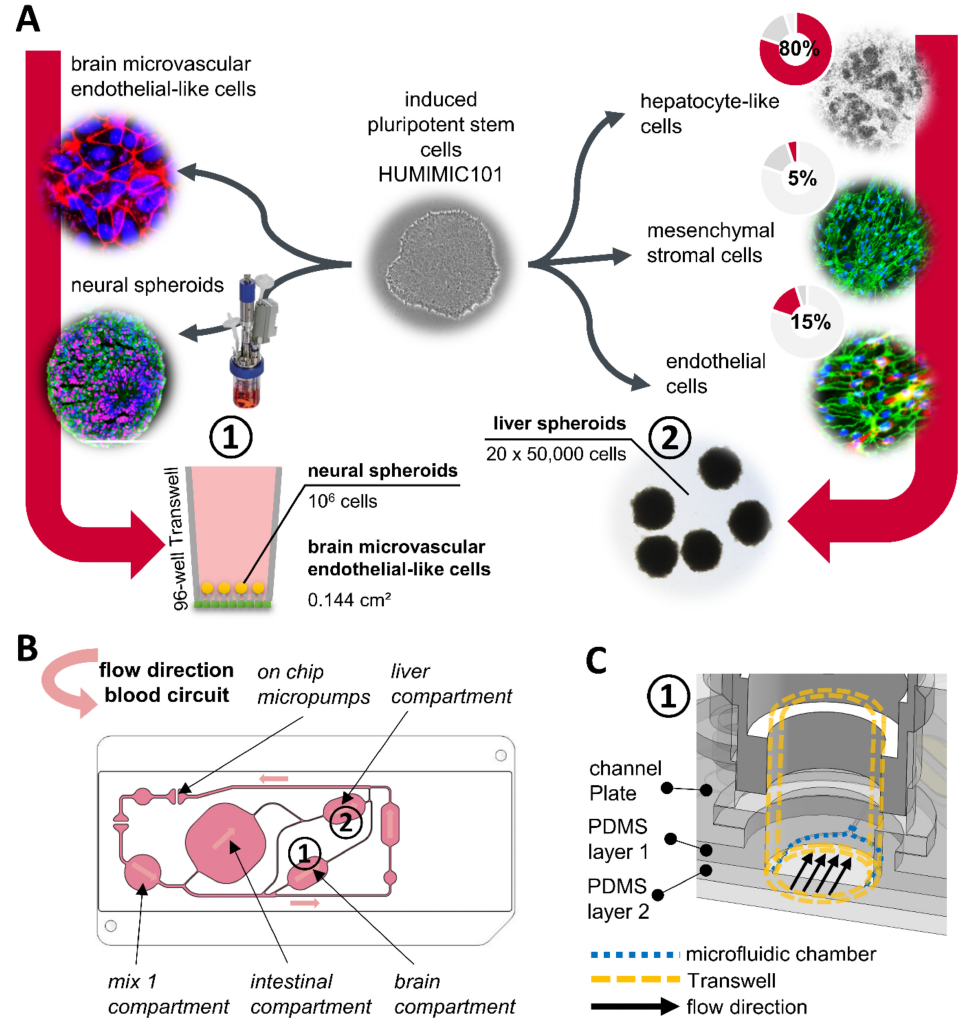
Figure 1. Setup of the iPSC-derived BBB/brain and liver coculture assay in the HUMIMIC Chip4. ( A ) Schematic iPSC differentiation of the HUMUMIC101 iPSC line into brain microvascular endothelial-like cells, neural spheroids, endothelial cells, mesenchymal stromal cells and hepatocyte- like cells. Brain microvascular endothelial-like cells and neural spheroids were combined in 96-well Transwells to build a blood–brain-barrier / brain model 1 (cid:13) . The endothelial cells, mesenchymal stromal cells and hepatocyte-like cells were combined in spheroids of 50,000 cells, and 20 of those spheroids per chip were used as a liver model 2 (cid:13) . ( B ) 2D view of the HUMIMIC Chip4 microfluidics; the surrogate blood circuit is shown in pink. In the depicted circuit a medium reservoir (mix 1) is interconnected with a 24-well intestinal compartment and 96-well compartments for the liver 1 (cid:13) and BBB/brain 2 (cid:13) model. The fluid flow is created by on-chip micropumps; the direction of the flow is indicated by arrows. ( C ) 3D view of the brain culture compartment 1 (cid:13) in the HUMIMIC Chip4. The bottom of the compartment consists of the PDMS layer 2. At the sides, the compartment consists of the PDMS layer 1 and the channel plate. Cut-off 96-well Transwells (yellow dotted line) can be inserted into the compartment and stand at their edges on a 100 µ m high step of PDMS layer 2. Endothelial cells cultured at the bottom of the Transwell membrane are thereby directly exposed to the fluid flow passing